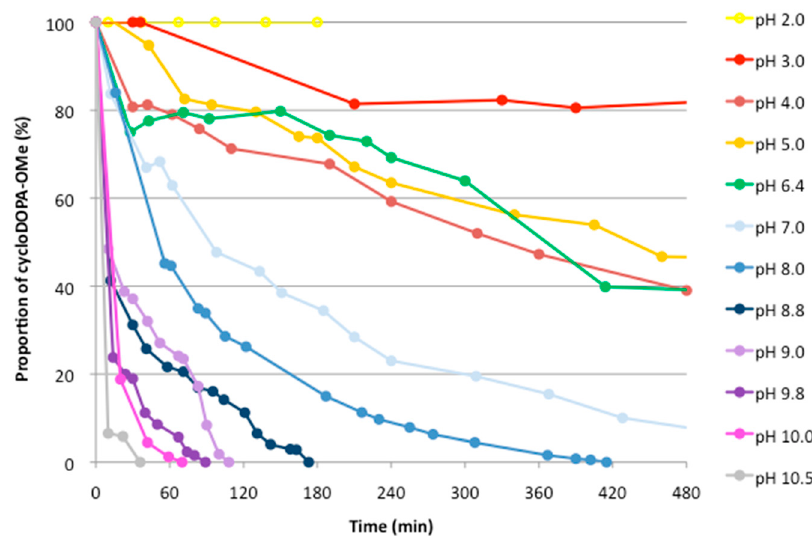
Figure 4. pH stability of cycloDOPA-OMe ( 6 ) in a D 2 O solution. Solutions of cycloDOPA methyl ester